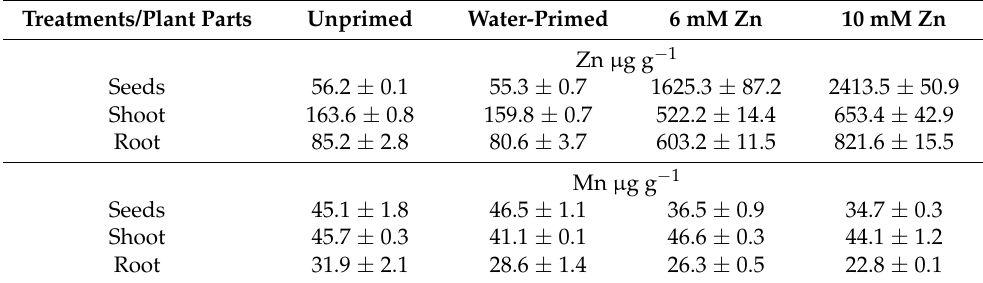
Table 1. Zinc and Mn concentrations in spinach seeds, shoots and roots of young seedlings after water, and Zn seed priming. Values represent the mean and standard error (SE) of four replicates. Treatments/Plant Parts Unprimed Water-Primed 6 mM Zn